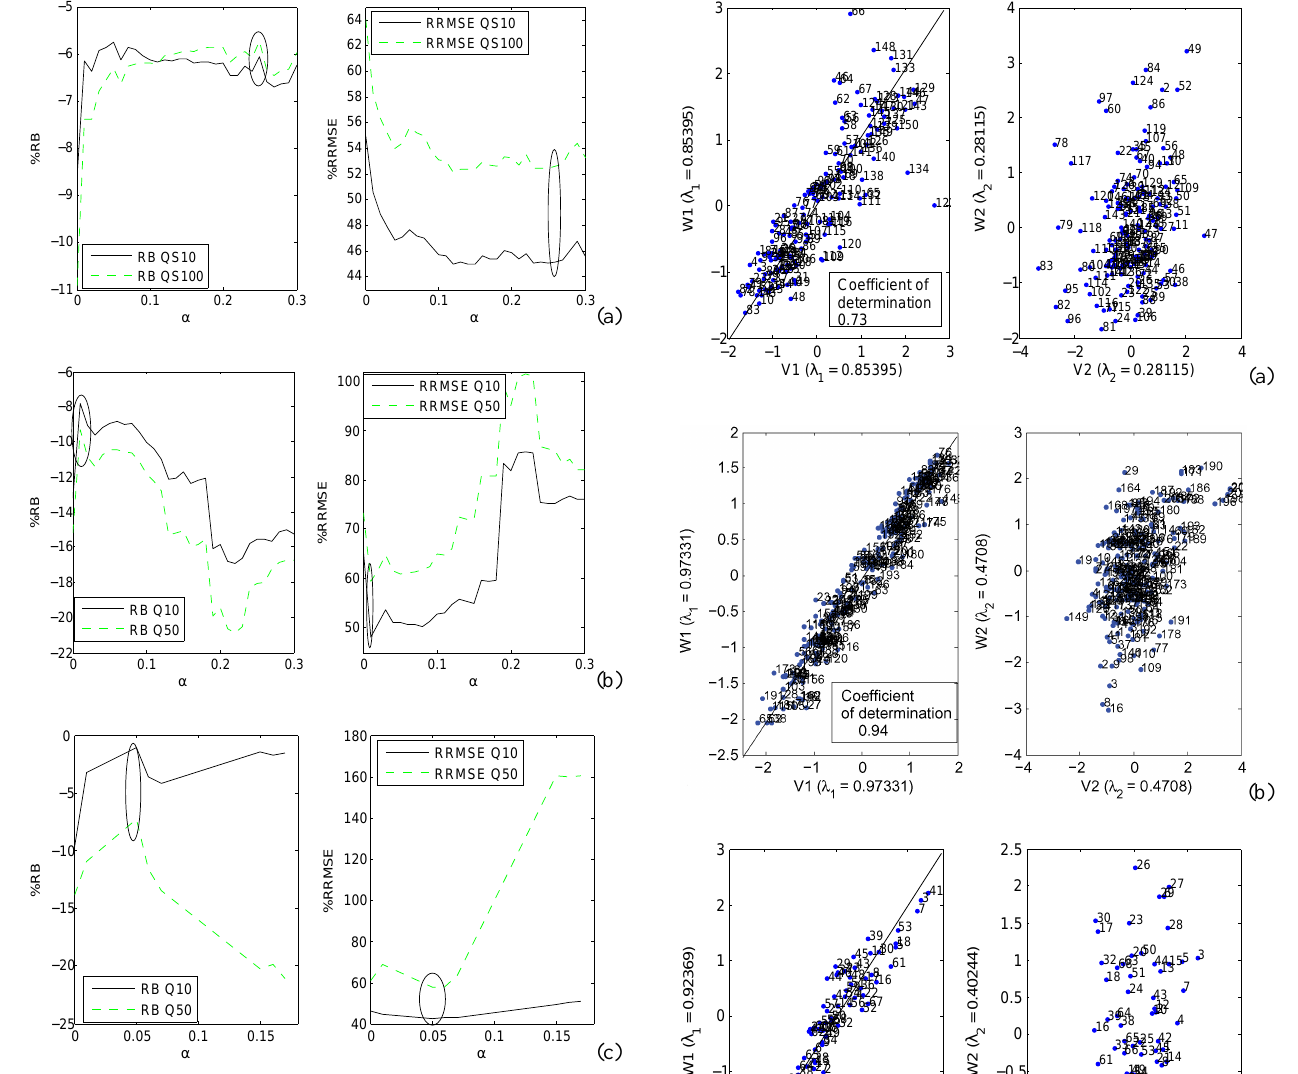
Fig. 3. Optimal value of the neighborhood coefficient α for the CCA approach for (a) southern Quebec, (b) Arkansas and (c) Texas. The first column illustrates the RB and the second column illustrates the RRMSE.